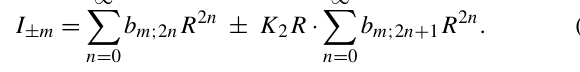
(cid:112) 3 + η 2 for η =